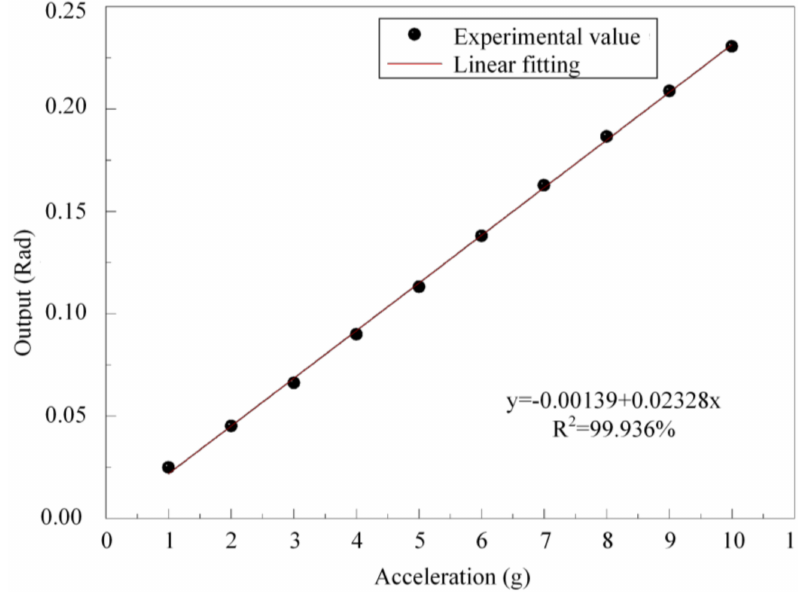
Figure 6. Linear fitting of the FOFPA.